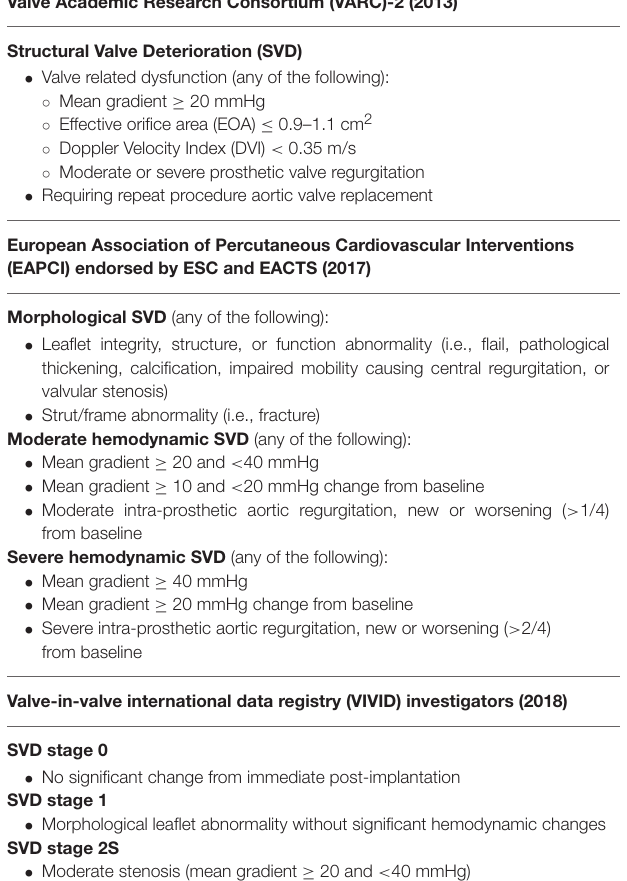
TABLE 1 | Proposed definitions of structural valve deterioration (SVD). Valve Academic Research Consortium (VARC)-2 (2013) Structural Valve Deterioration (SVD) • Valve related dysfunction (any of the